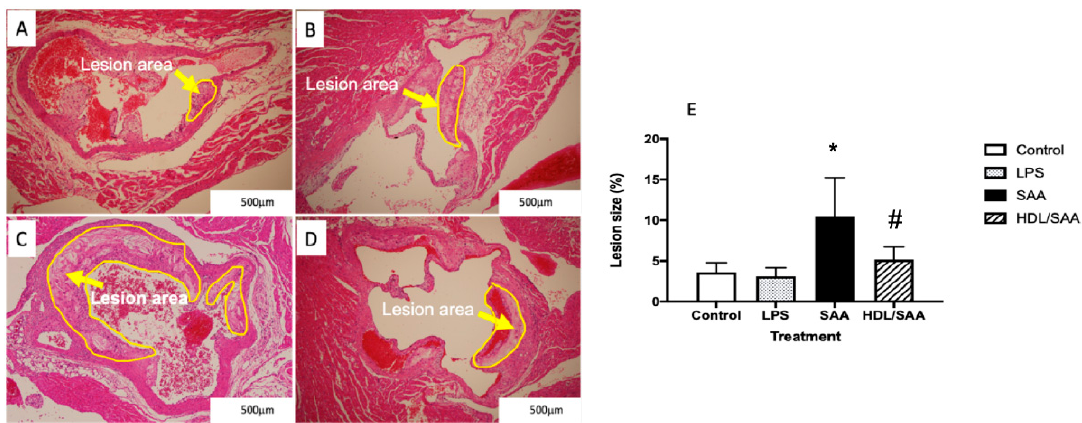
Figure 1. Pretreatment with HDL inhibits SAA-induced aortic lesion in ApoE − / − mice. Male ApoE − / −